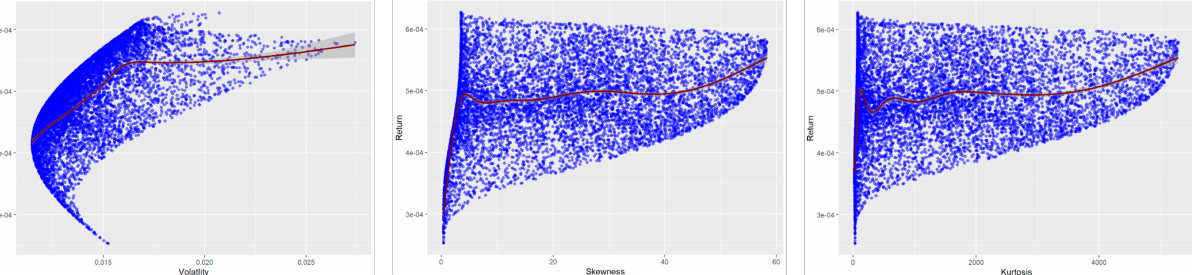
Figure 6. Scatterplot demonstrating relationship between portfolio return, skewness, and kurtosis of Cryptocurrencies (Group 2).